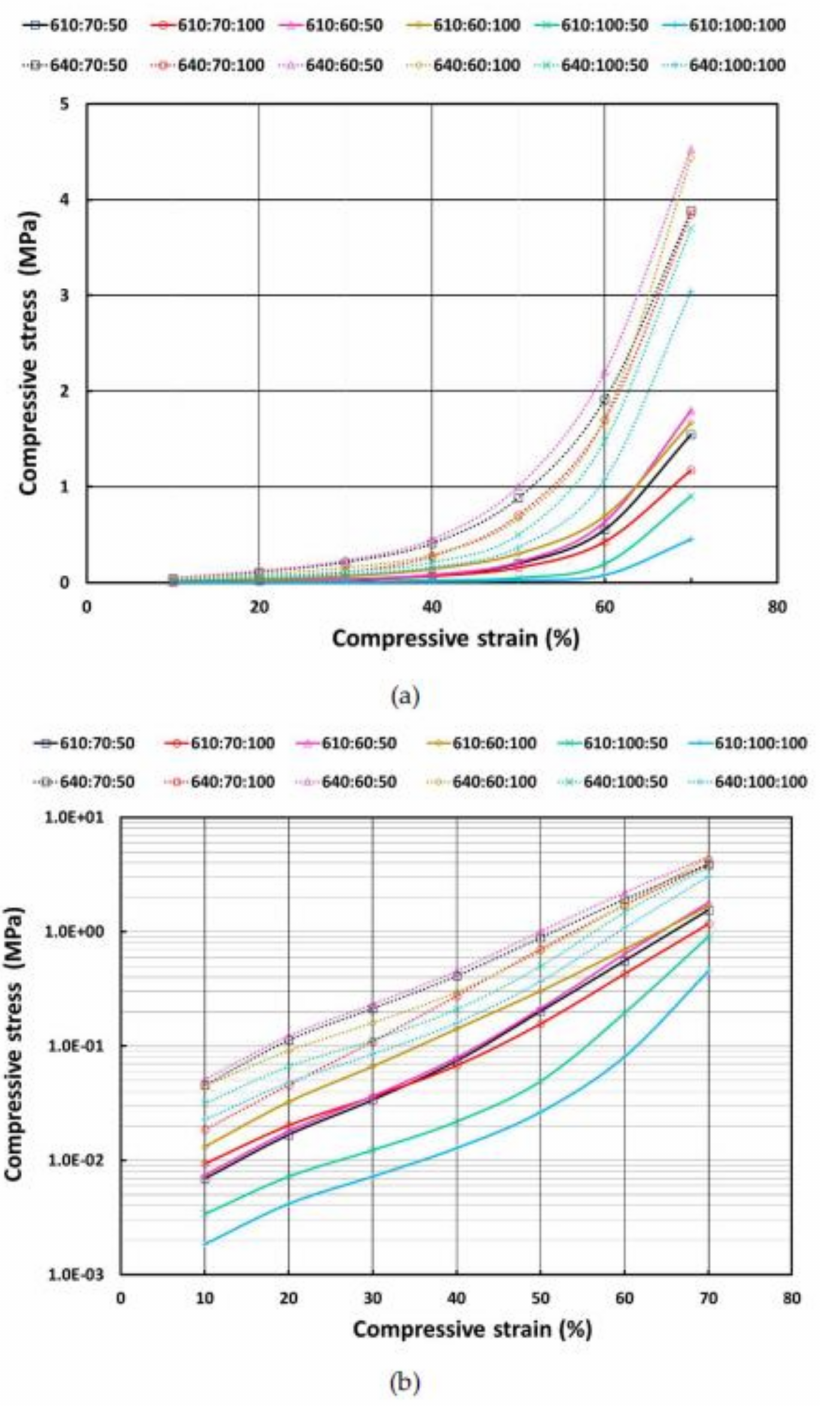
Figure 12. Stress at loading stop strain in cyclic compression of all porous samples ( a ); corresponding logarithmic plots (of stress) ( b